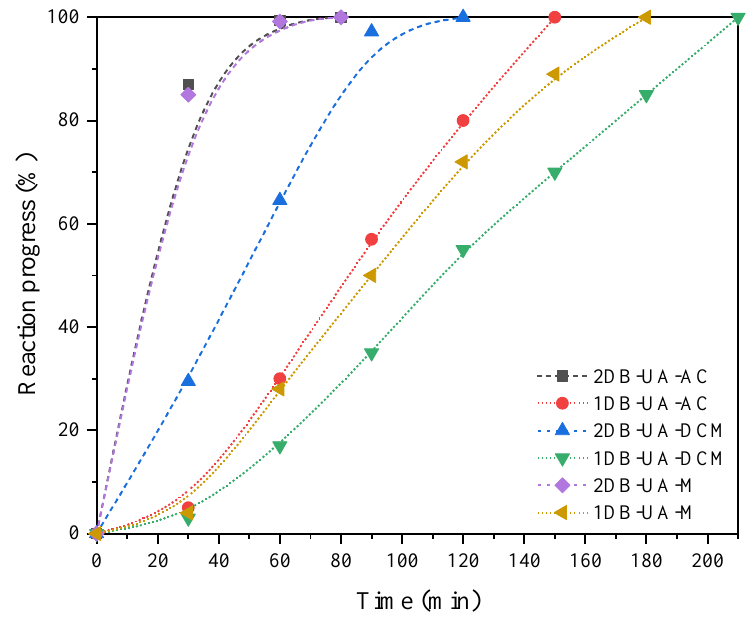
Figure 5. Monitoring of disappearance of NCO peak with the progressive addition of PDO to the isocyanate-bearing urethane acrylates while considering the use of solvent.